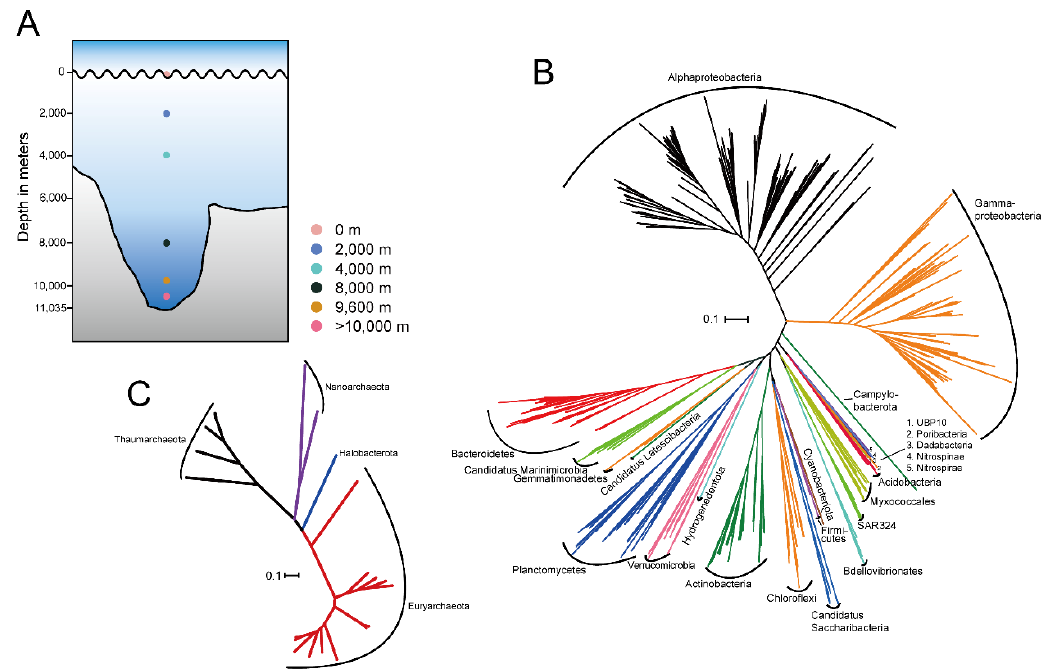
Figure 1. Sampling sketch and phylogenetic inference of metagenome-assembled genomes (MAGs). ( A ) Sampling sketch across a seawater column in the Mariana Trench. Phylogenetic inference of 693 bacterial MAGs ( B ) and 33 archaeal MAGs ( C ) based on 120 and 122 single-copy, protein-coding marker genes, respectively. All MAGs were assigned to 28 clusters represented by di ff erent branch colors. The scale bar represents 0.1 substitutions per